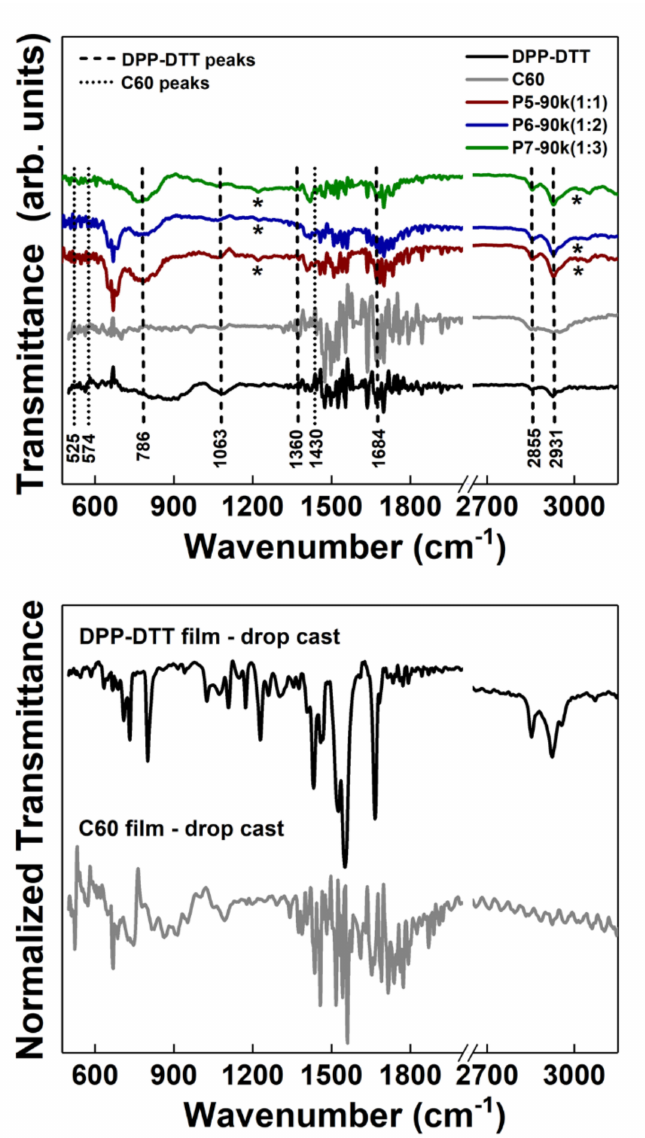
Figure 2. FTIR spectra of the thin films deposited by MAPLE on silicon and of the single components (DPP-DTT and C60) obtained by drop casting. * Peaks attributed to